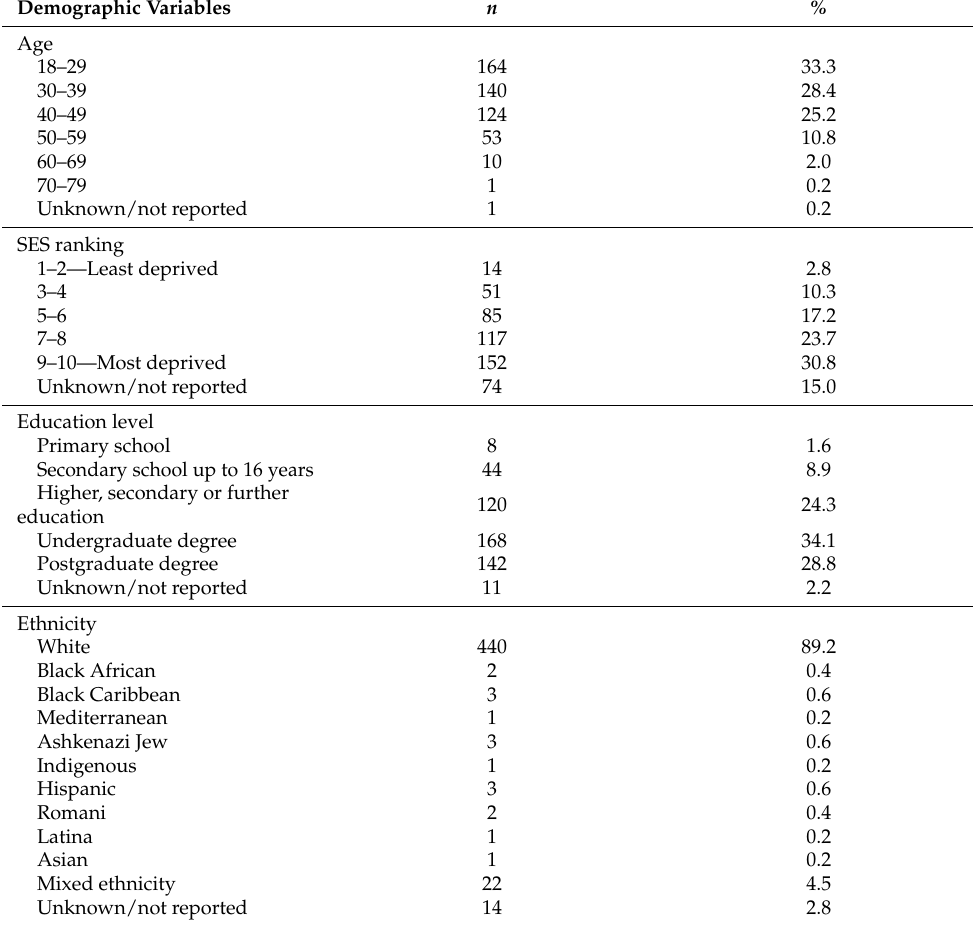
Table 1. Summary of autistic adults’ demographic